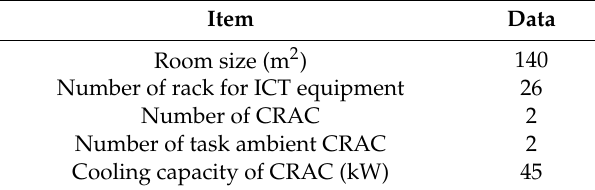
Figure 2. System configuration.